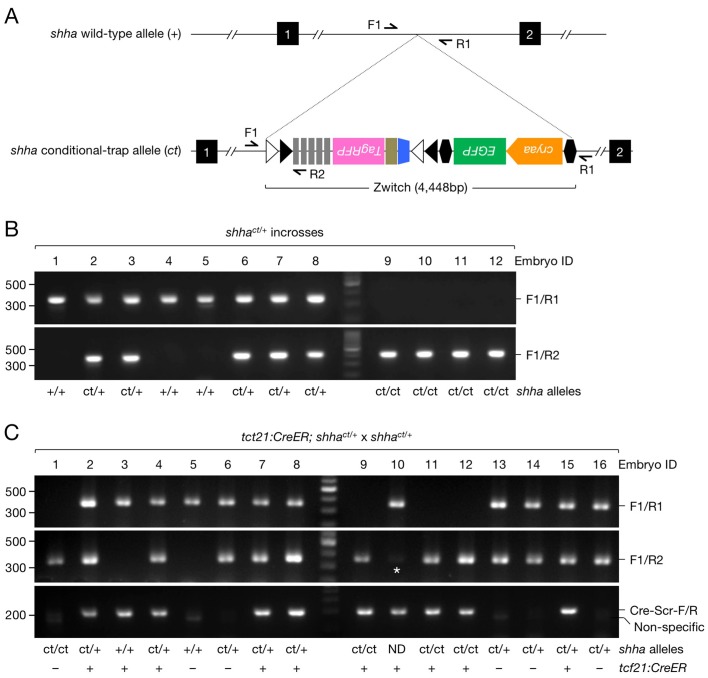
Genotyping PCR of shhact alleles.(A) Schematic of the shha WT allele (+) and conditional trap allele (ct) and primers sites. (B) Genotyping PCR result of single embryos from an incross of shhact/+ fish injected with Cre DNA at single-cell stage. Note that ct/ct genotype was predictable due to the developmental defects observed in shhact/ct embryos after Cre DNA injection. (C) Genotyping PCR result of single embryos from a cross of tcf21:CreER; shhact/+ fish with shhact/+ fish. We did not use embryos exhibiting a faint band for experiments (asterisk). PCR with Cre-Scr-F/R primers occasionally amplified a faint non-specific band at a lower size. ND, not determined. Please see the Genotyping and Sample preparation for embryo genotyping and analysis section in the Materials and methods for details of the screening procedures.